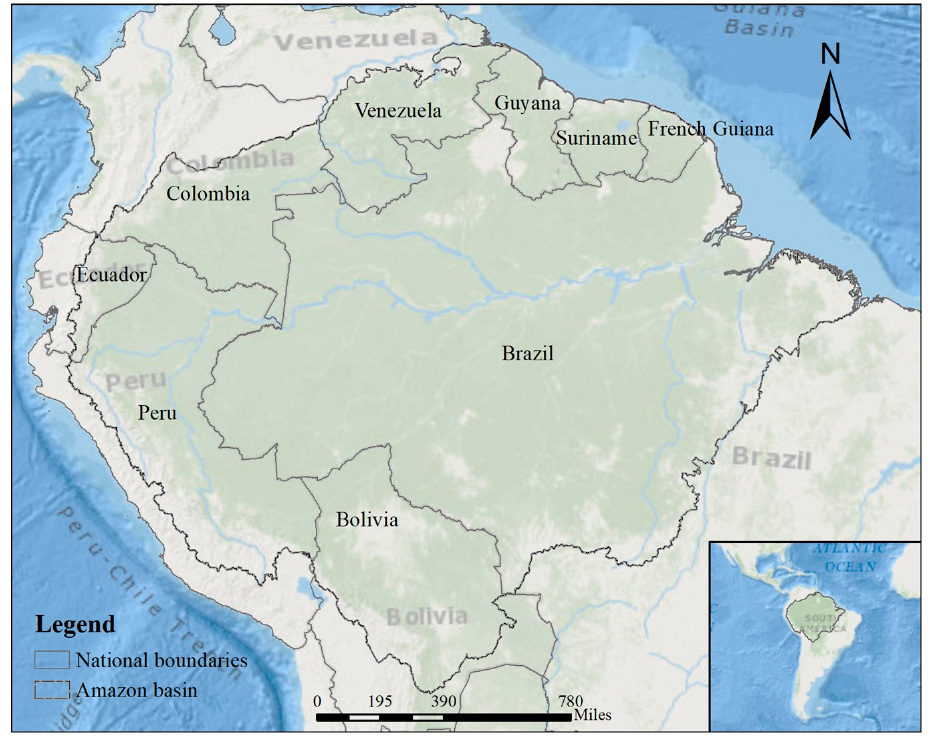
Figure 6. The study area of the Amazon basin in South America.